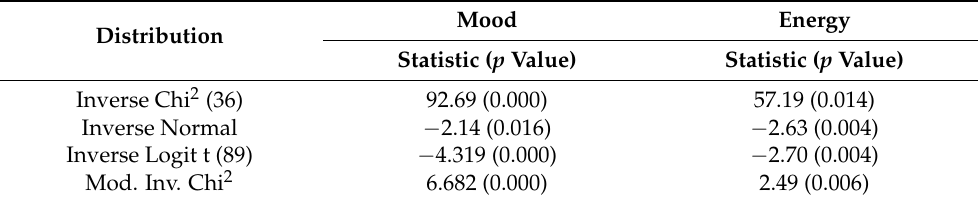
Table A2. Fisher-type unit-root test based on augmented Dickey–Fuller (ADF) tests for Mood and Energy.